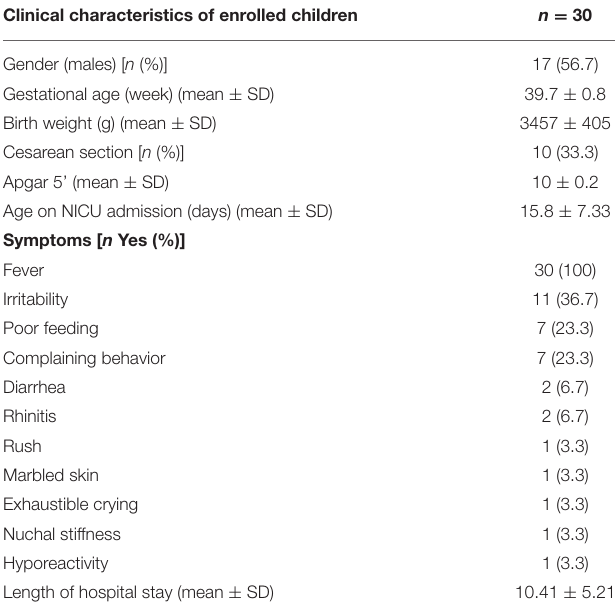
TABLE 2 | Characteristics of CSF in neonates with meningitis. Chemical